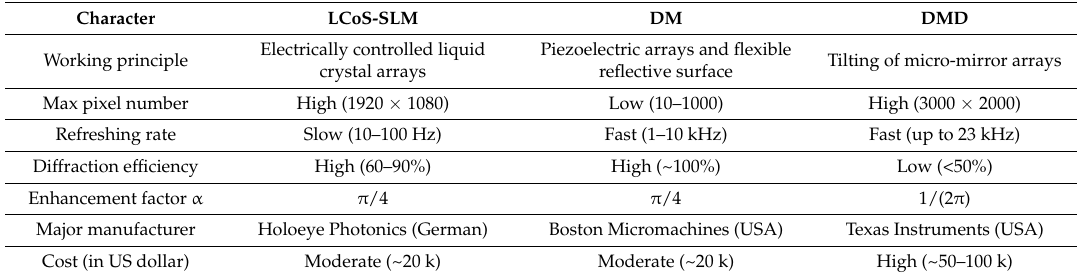
Table 1. Representative commercial wavefront modulators 1 (modified from